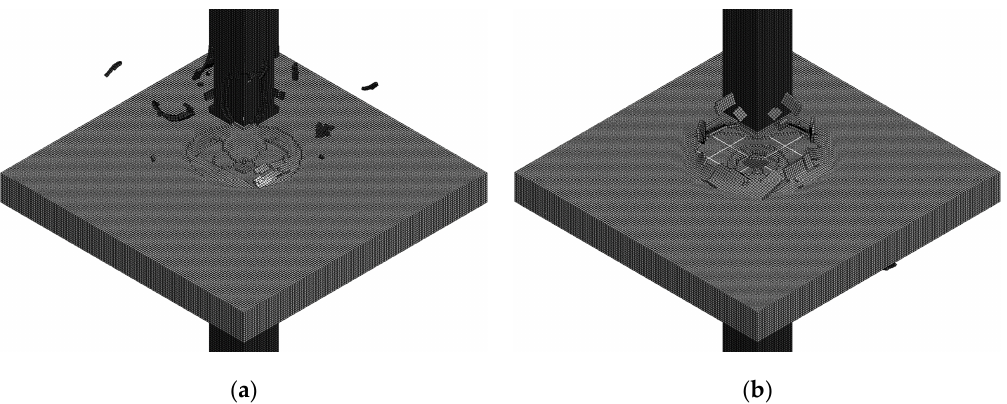
= 0.067 m / kg 1 / 3 ); ( a ) Top surface; ( b ) Bottom Figure 6. Failure shapes (30 kg, Z = 0.067 m/kg 1/3 ); ( a ) Top surface; ( b ) Bottom surface Figure 6. Failure shapes (30 kg, Z